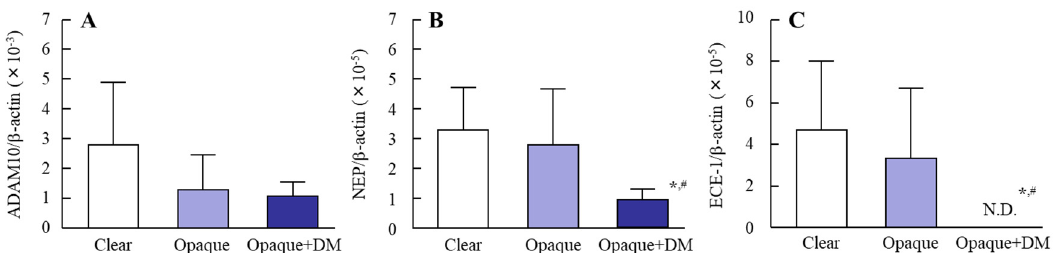
Figure 4. Changes in ADAM10 ( A ), NEP ( B ), and ECE-1 ( C ) mRNAs in lens epithelium of diabetic patients. Patient characteristics are shown in Table 1 (PCR method group). Open columns, transparent lens epithelium; closed columns, opaque lens epithelium. Clear, transparent lens epithelium; opaque, opaque lens epithelium; opaque + DM, opaque lens epithelium with type 2 DM. N.D., not detectable. n = 3–15. * p < 0.05, vs. clear for each group. # p < 0.05, vs. opaque for each group. Table 3. Approximation formulas and correlation coefficients ( r ) between of plasma glucose and A β accumulation in human lens epithelium. vs. Glucose Approximation Formula r Total-A β levels